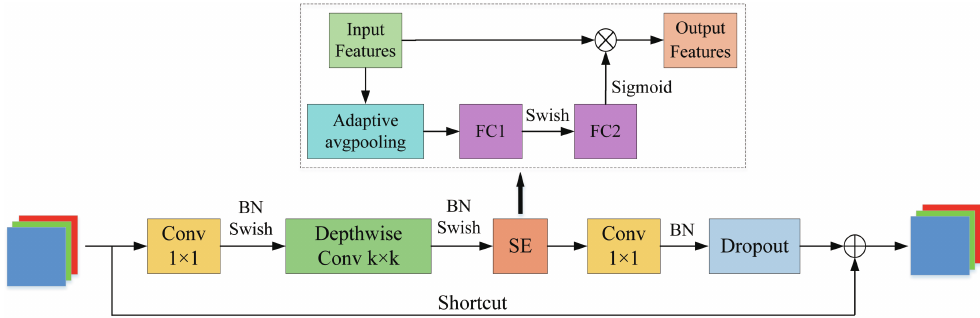
Figure 3. Detailed architecture of MBConv. Conv denotes a convolution layer, FC denotes a fully con- nected layer, BN denotes a batch normalization layer and SE denotes a squeeze-and-excitation